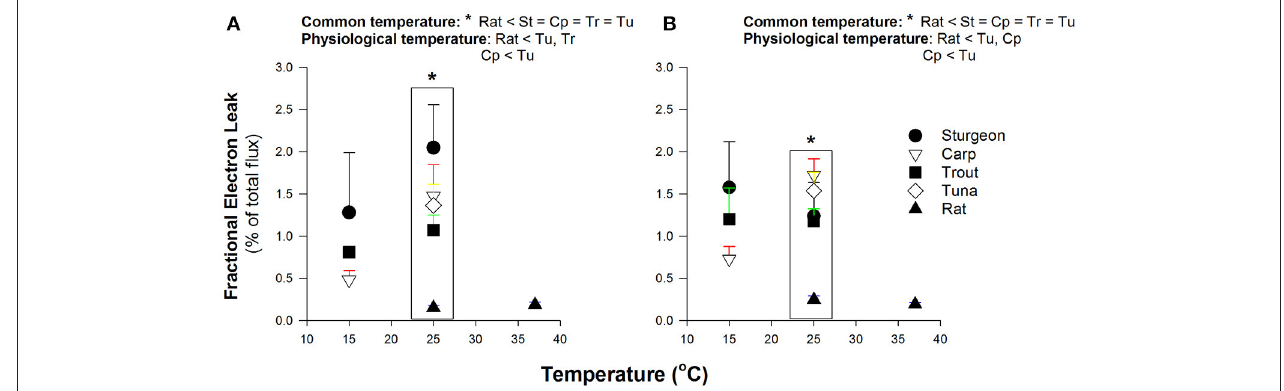
FIGURE 3 | Fractional electron leak by isolated muscle mitochondria. Data are mean ± SEM ( n = 3–5 depending on species) and substrates were 5 mM pyruvate and malate (A) or 0.05 mM D/L-palmitoylcarnitine and 5 mM malate (B) . Assay temperature is indicated and contrasts were made at a common temperature (indicated by * and brackets) or physiological temperatures as indicated within figures. Physiologically relevent temperatures are 15 ◦ C for sturgeon, carp and trout; 25 ◦ C for Pacific bluefin tuna; 37 ◦ C for rat. Species abbreviations are as indicated in Figures 1 , 2